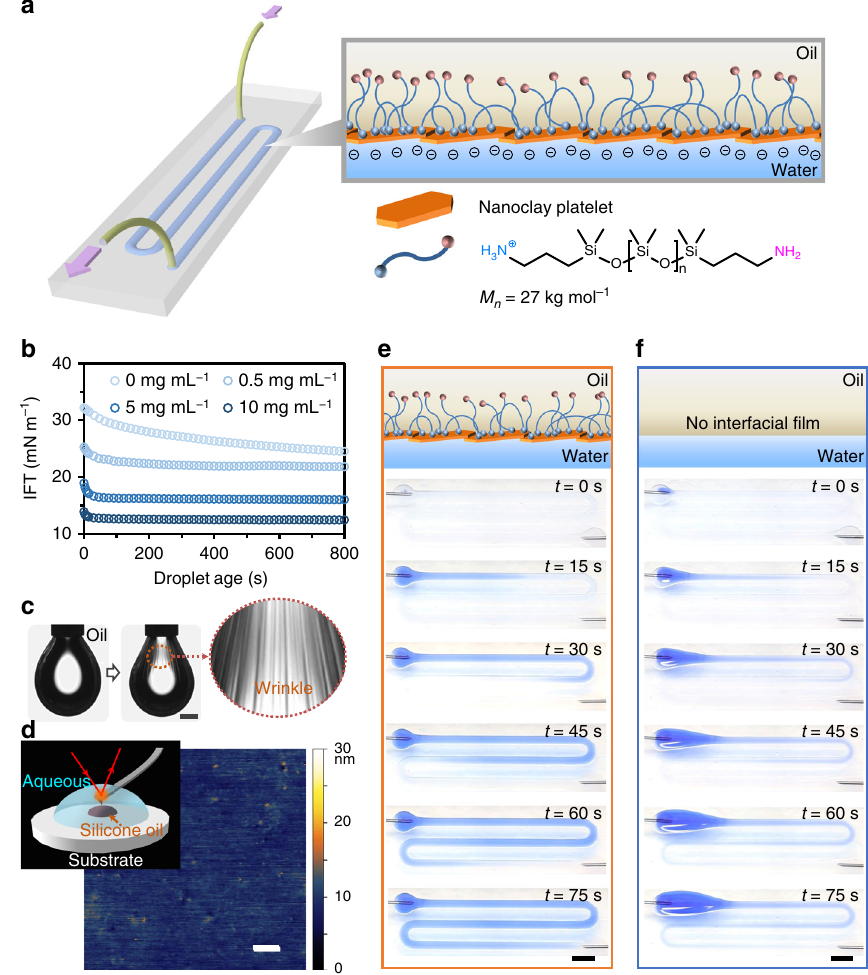
Fig. 1 All-liquid fl uidic devices stabilized by NPS membranes. a Schematic of an all-liquid fl uidic device comprised of immiscible liquid phases con fi ned in space using superhydrophobic − superhydrophilic micropatterned substrates. Nanoclay – polymer surfactants (NPSs) self-assemble at the liquid – liquid interface, forming an elastic wall that allows the all-liquid architecture to maintain integrity while fl uid is pumped through the channel. b Temporal evolution of interfacial tension (IFT) of aqueous nanoclay dispersions (0.5, 5, and 10 mg mL − 1 , pH 7.0) introduced to solutions of H 2 N-PDMS-NH 2 in toluene (10% w/w), illustrating control over the rate of NPS assembly at the interface. c Buckling behavior observed when retracting a droplet cladded with the interfacial NPS fi lm. Scale bar, 1 mm. d In-situ AFM image of the NPS fi lm. The inset shows the schematic diagram of the experimental setup for AFM measurements. Scale bar, 100 nm. e , f Time-lapse images of a solution of blue-colored dye being pumped (10 mL h − 1 ) through the channel in the presence ( e ) and in the absence ( f ) of the NPS fi lm. Scale bars, 5 mm. AFM atomic